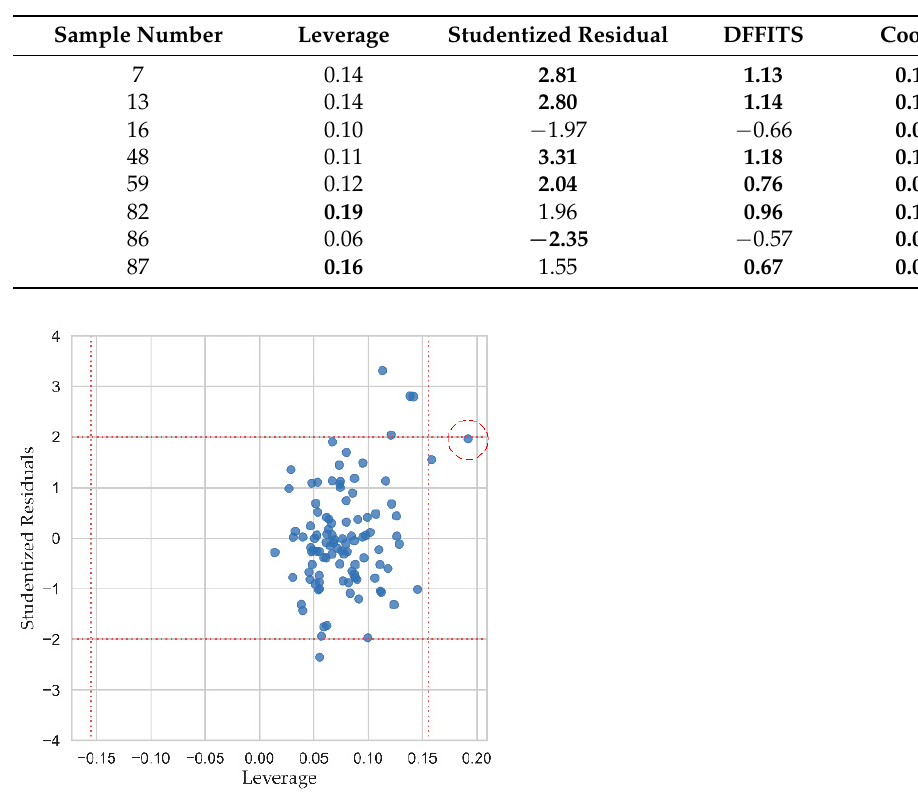
Figure 5. Student residuals and leverage values. Table 5. Samples that exceed the thresholds of Leverage, Studentized Residual, DFFITS, and Cook’s: the value in bold indicates that the threshold is exceeded.